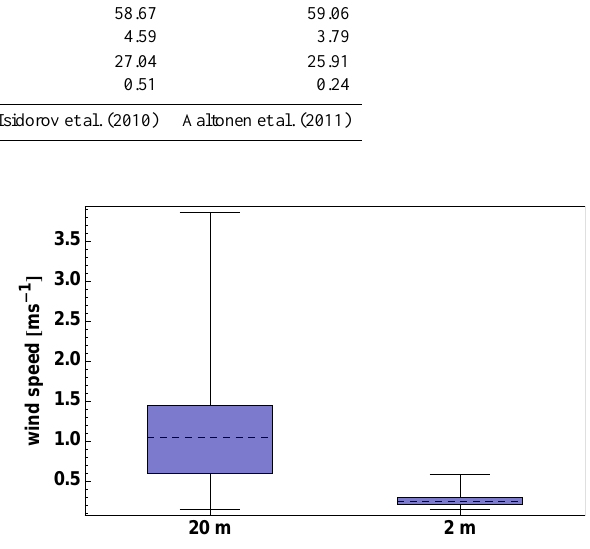
Fig. 2. Example for the variation of the wind speed above (20 m) and within the forest canopy (2m). The data were measured during August 2009. The monthly median wind speed at 20 m height was 1.04 ms − 1 and at 2 m height dropped to 0.25 ms − 1 . The boxes cover 50 % of the data.